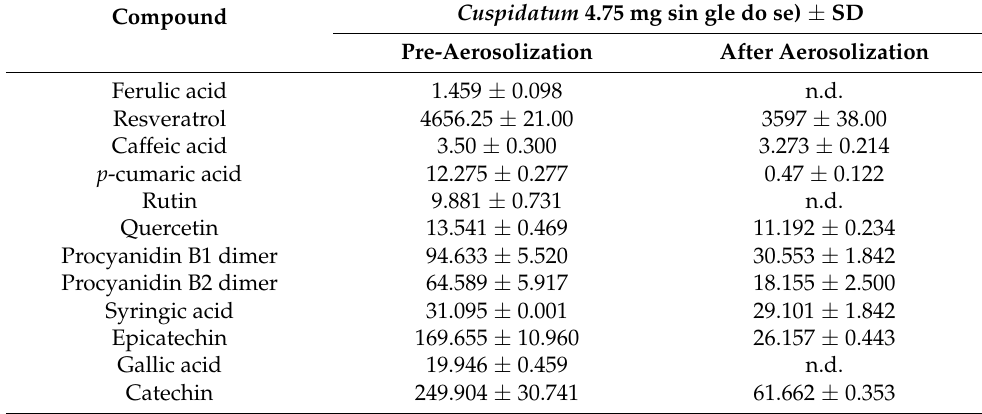
Table 1. High-performance liquid chromatography-diode-array detector (HPLC-DAD) analysis of the main polyphenols contained in the formulation Taurisolo ® + Polygonum cuspidatum, before and after aerosol. Values are expressed in µ g per single dose of Taurisolo ® 100 mg + Polygonum cuspidatum 4.75 mg ± standard deviation of three repetitions. Mean Value ( µ g/Taurisolo ® 100 mg + Polygonum Cuspidatum 4.75 mg sin gle do se) ± SD Compound Pre-Aerosolization After Aerosolization Ferulic acid